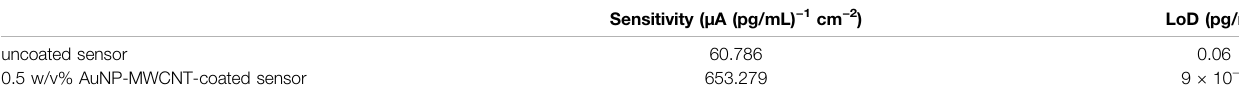
TABLE 2 | Performance comparison of the IL-6 sensor with and without the AuNP-MWCNT coating.